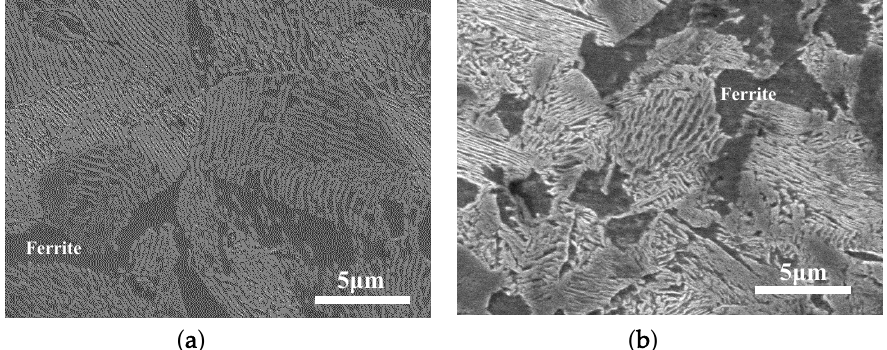
Figure 5. Metallographic microscope images of wheel materials. (a) D1; (b) D2.